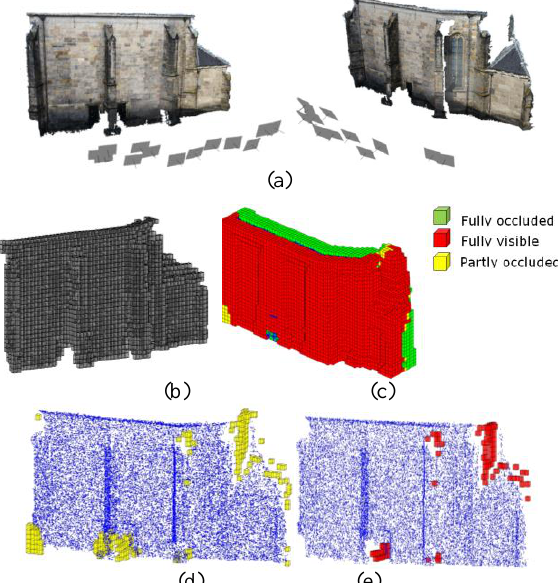
(e) Figure 21. Gap detection with voxels. (a) The dense point cloud. (b) The occupied voxels. (c) The empty voxels and visibility analysis. (d) The detected empty voxels after visibility analysis. (e) Final occluded gaps after neighborhood